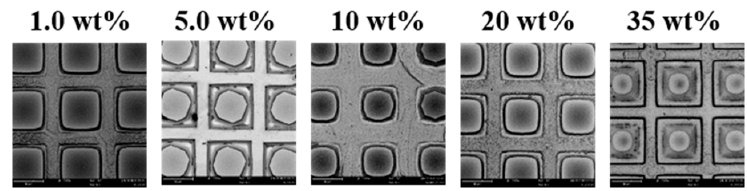
Figure 5. First layer micropyramids shape varies with KOH concentration. All samples were 50 μ m × 50 μ m square patterns with gap of 5 μ m. The samples were first etched in 10 wt % HF solution for 2.0 min. The KOH etching time was 10 min and temperature was 70 °C.